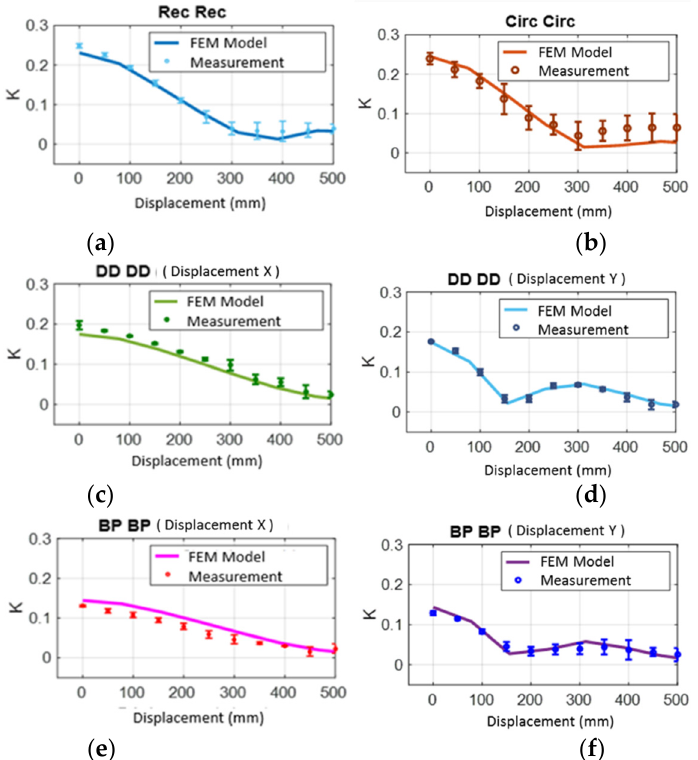
Figure 23. Comparison of the coupling coefficient measured and simulated for different topologies of coils for a displacement in the axis of the electric road. ( a ) rectangular; ( b ) circular; ( c ) DDX; ( d ) DDY; ( e ) BPX; ( f ) BPY.